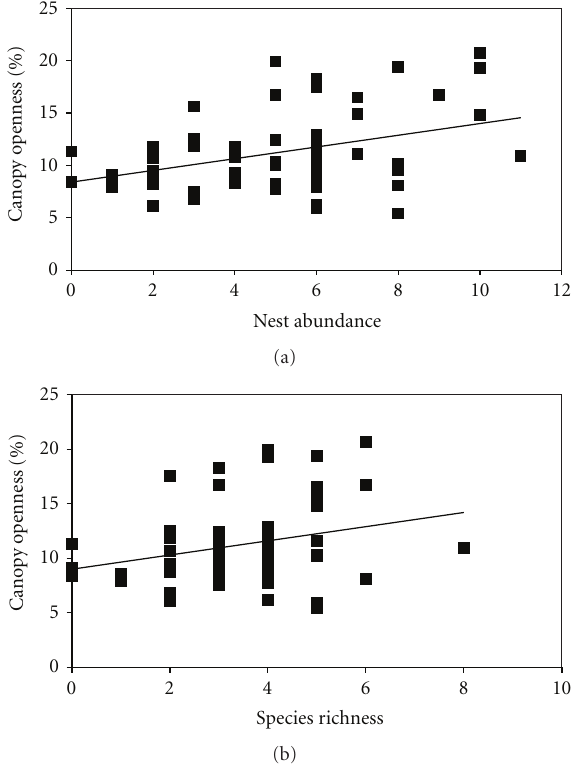
Figure 3: Relationship between canopy cover and the nest abun- dance (a) and species richness (b) in undecomposed twigs in the leaf litter in dense ombrophilous rainforest